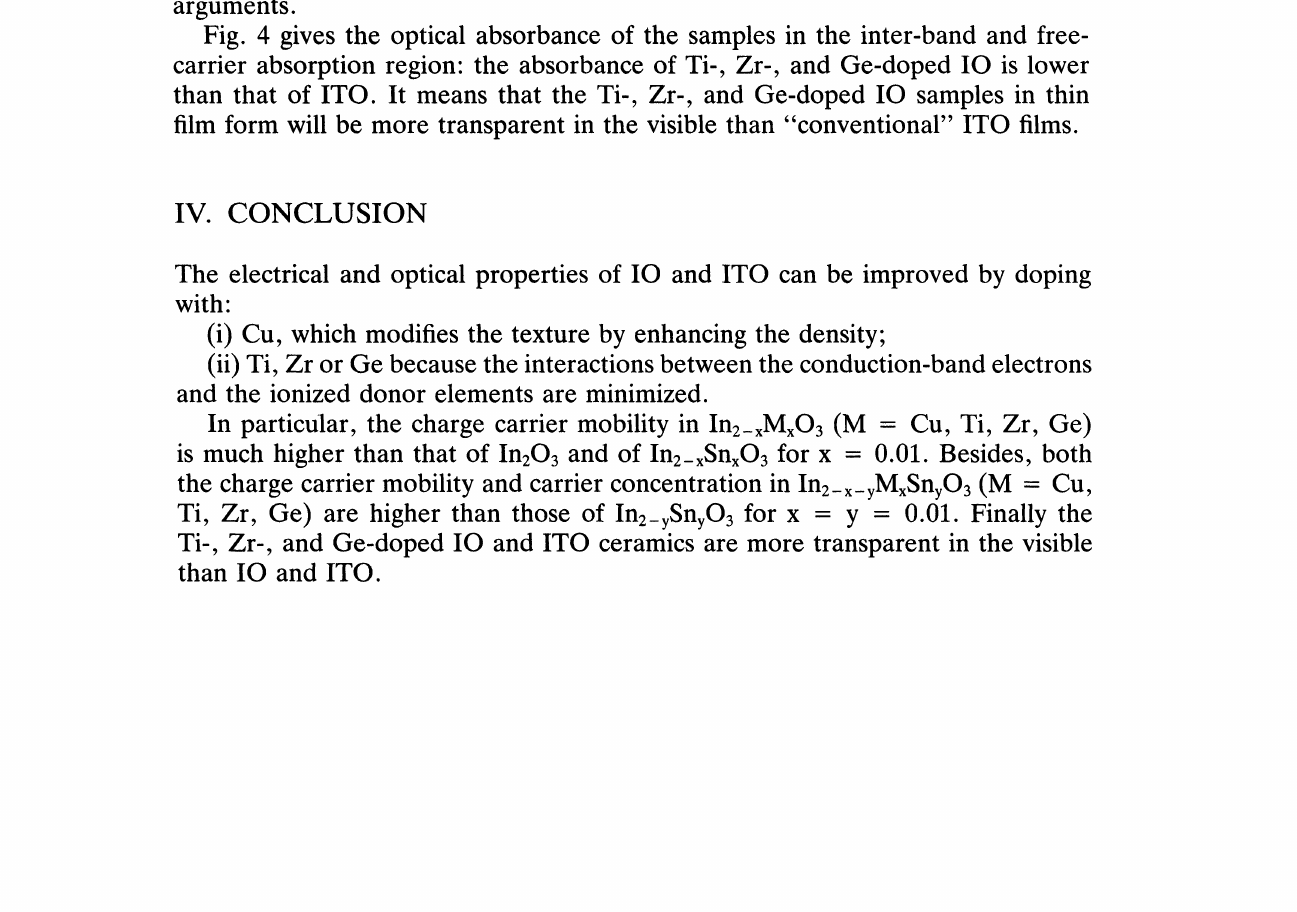
FIGURE 4 Absorbance versus the wavelength for various ceramics. The letters alonside the curves have the same meanings as in fig. 2 and fig.